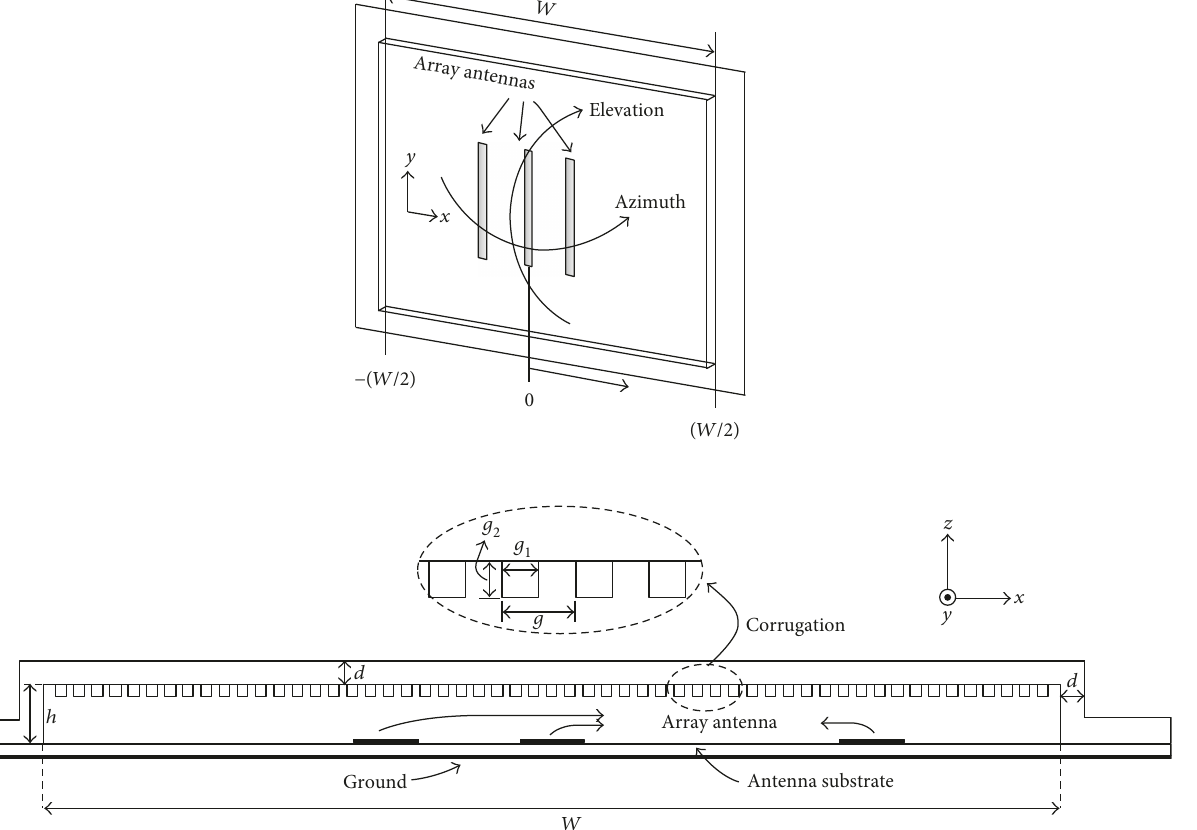
Figure 1: Corrugated radome.